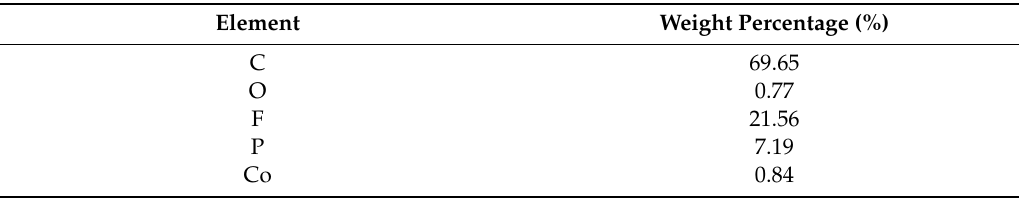
Table 1. Weight percentage of the elements present in the surface of the system Gr / IL / Co obtained by FESEM-EDX.